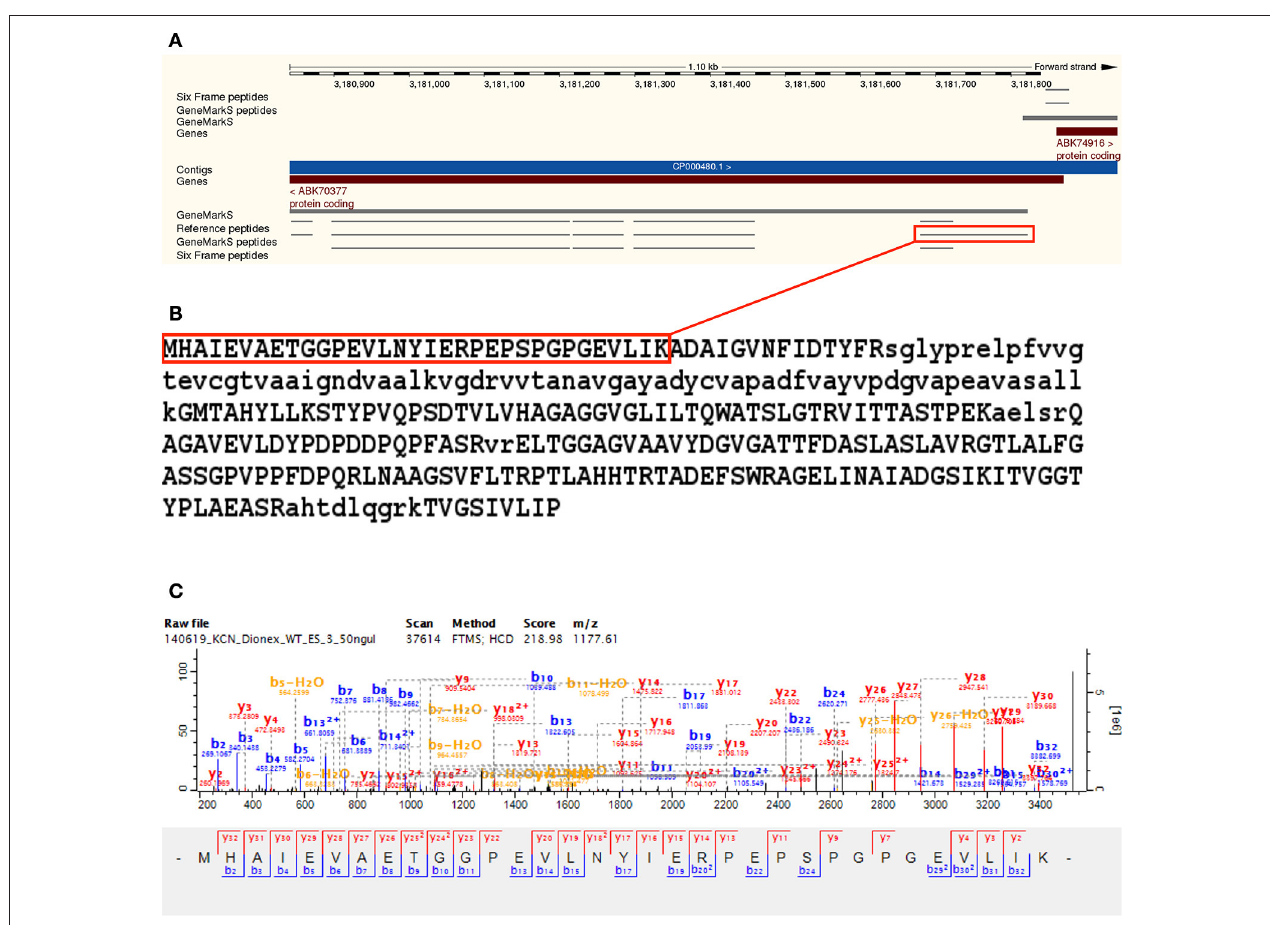
FIGURE 6 | Downstream gene model modification — A0QWY3. Illustrates the downstream modification of an annotated predicted gene model A0QWY3 by 16 amino acids, with the identification of a TSS peptide MHAIEVAETGGPEVLNYIERPEPSPGPGEVLIK with a non-tryptic N-terminal downstream of the annotated TSS. In this case, the downstream TSS peptide corresponded to the N-terminal of the GeneMarkS predicted sequence for this ORF, thus allowing this semi-tryptic TSS peptide to be included in the GeneMarkS database search space. The modified sequence is identical to I7G8G0, predicted for the same strain but not included in the Reference proteome. Panel (A) visualizes the identified peptides using the Ensembl genome browser, with the downstream TSS peptide highlighted in red. The downstream gene model modification of A0QWY3 corresponds with the simultaneous upstream gene model modification of A0QWY4 on the opposite strand, supporting both reannotations. Panel (B) illustrates the modified gene model, with the TSS peptide highlighted in red. Panel (C) illustrates a representative MS/MS spectrum for the downstream TSS peptide, which was identified from 34 MS/MS scans using the GeneMarkS database